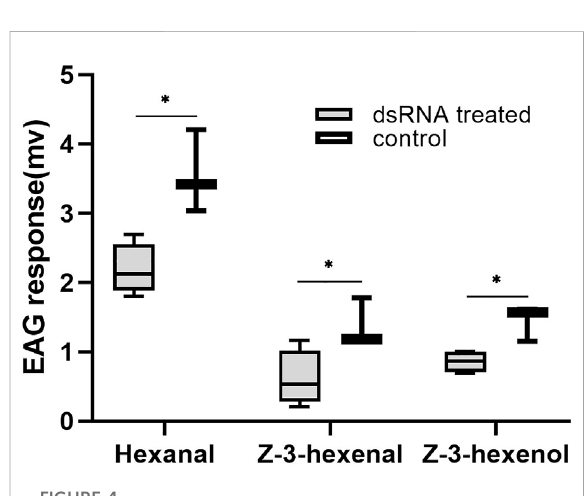
Electroantennogram (EAG) responses ofRNAi-treated D. tarsalis to host volatiles after 3 d *represents signi fi cant difference,**represents extremely signi fi cant difference (n = 4).